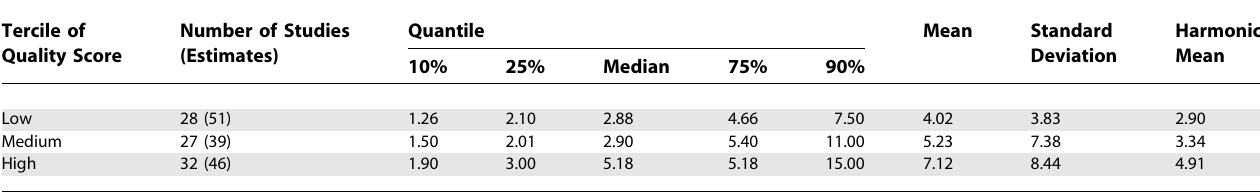
Table 13. Quantiles and Moments of Combined Prevalence Estimates per 1,000 for Persons by Tercile of Quality Score Tercile of Quality